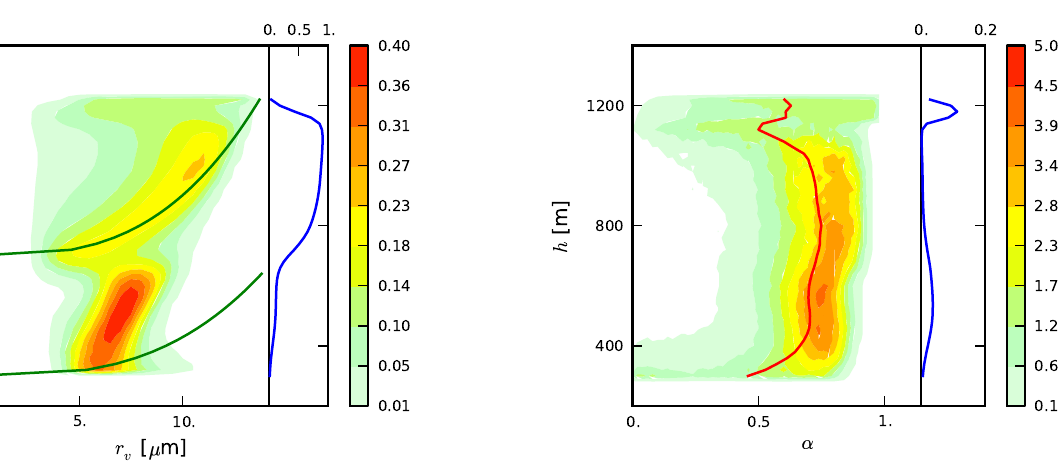
Fig. 12. CFAD of the droplet mean volume radius r v ; only cloudy points are included. Green lines show the adiabatic values of the ra- dius assuming the cloud base height and the adiabatic droplet con- centration of 300m and 60mg − 1 for the cumulus layer, and 700m and 90mg − 1 for the stratocumulus layer. The cloud fraction profile is shown on the right-hand side of the panel with the blue line.